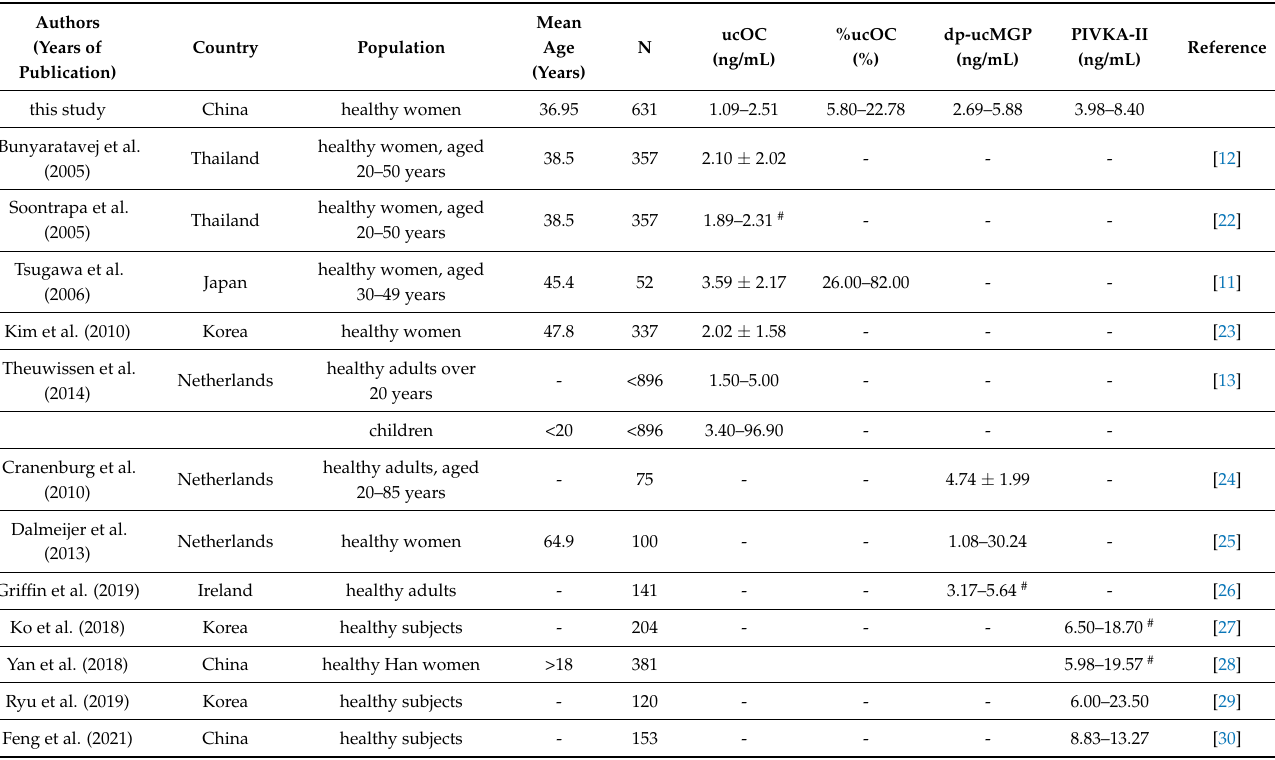
Table 7. Reference range or concentration for vitamin K-related indicators reported in